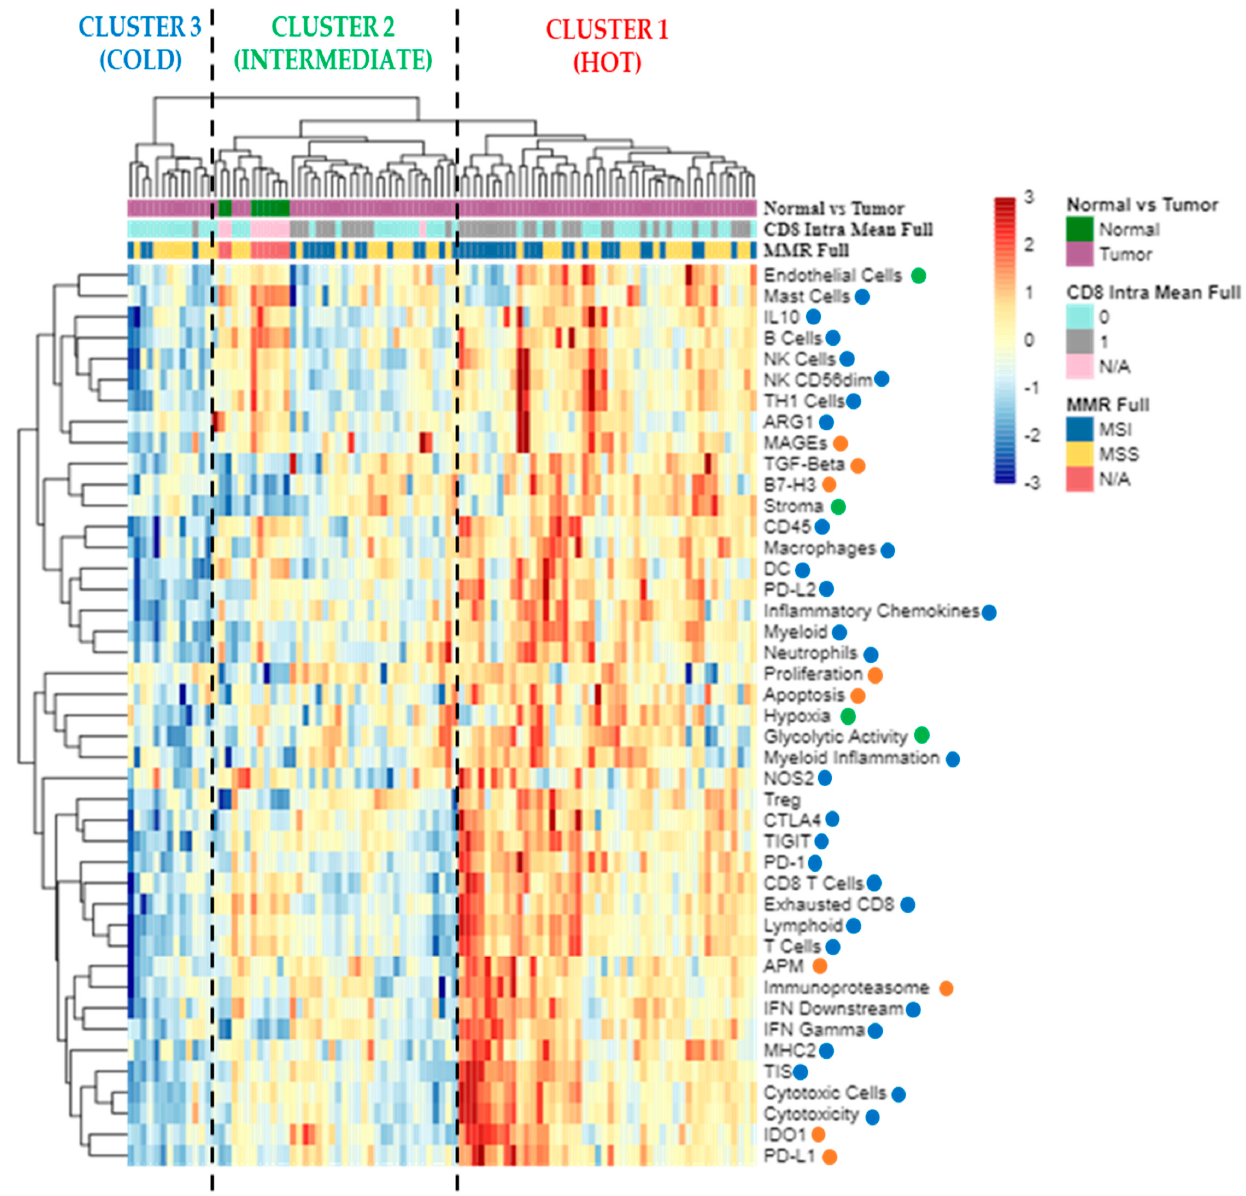
Figure 1. The ‘All Signatures’ heatmap uses unsupervised hierarchical clustering to show relatedness among signature scores for each sample. Scores are scaled by signature to have a mean of zero and a standard deviation of one. The standardized signature scores are truncated at ±3 standard deviations to preserve greater clarity in color change within the largest proportion of data (99% of the data should fall within ±3 standard deviations of the mean). Sample annotations are listed at the top of the heatmap: tumor vs. normal samples (violet vs. green); CD8 positive (category 1) vs. CD8 negative (category 0) CRCs (grey vs. light blue); MSI vs. MSS tumors (dark blue vs. yellow). The signatures are displayed in rows and listed to the right of the heatmap: red dots correspond to tumor signatures, green dots correspond to microenvironment signatures, and blue dots correspond to immune response signatures. Each column is a unique sample. Orange dots: tumor signatures; green dots: tumor microenvironment signatures; blue dots: immune response signatures; N/A, not available data; MMR, mismatch repair status; MSI, microsatellite unstable; MSS, microsatellite stable.